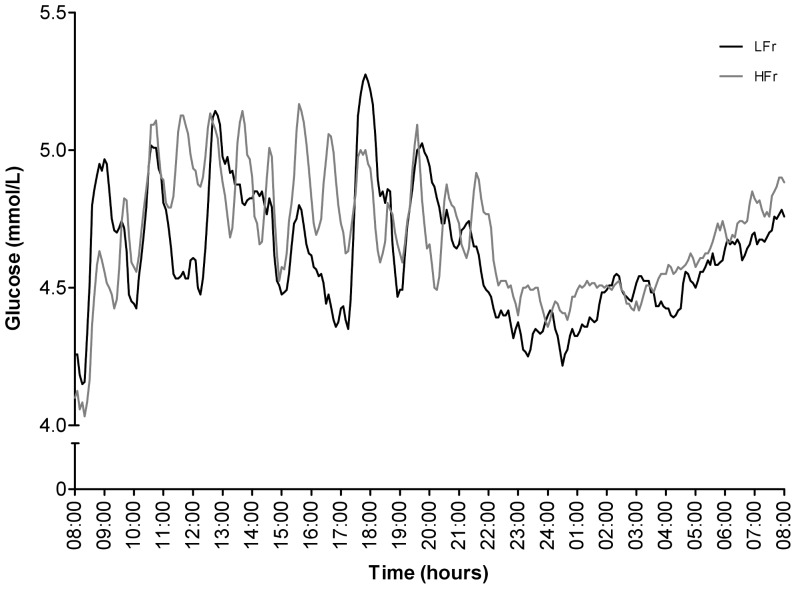
CGMS glucose levels for 24 h in the LFr and HFr diet.
aValues are expressed as mean.